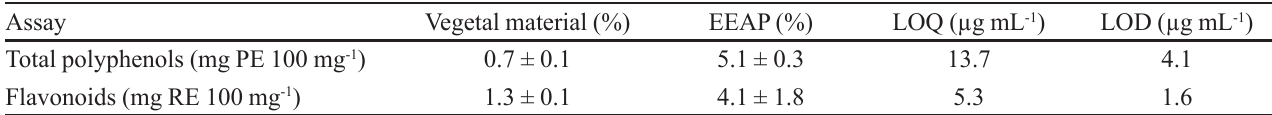
TABLE I - Quantification of total polyphenols and flavonoids in Alpinia purpurata leaves and ethanolic extract of AP (EEAP) Assay